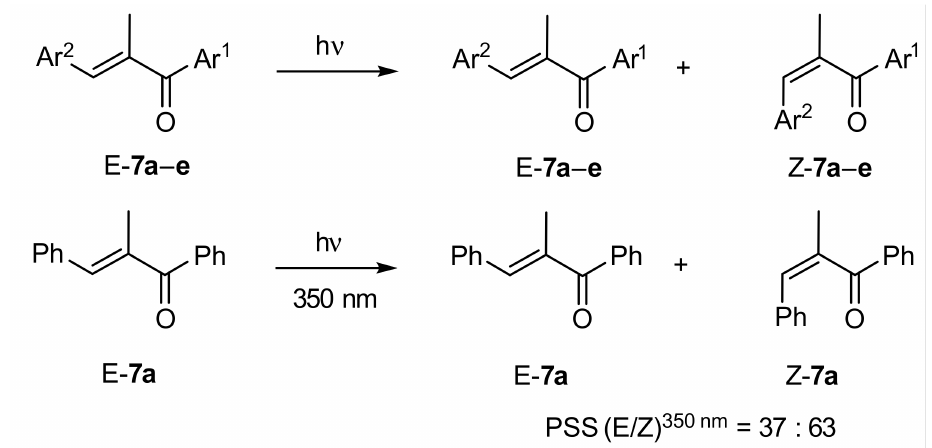
Scheme 4. Direct photochemistry of α -methyl chalcones 7 ; specific example for 7a at 350 nm; enone configurations were arbitrarily chosen (vide infra).